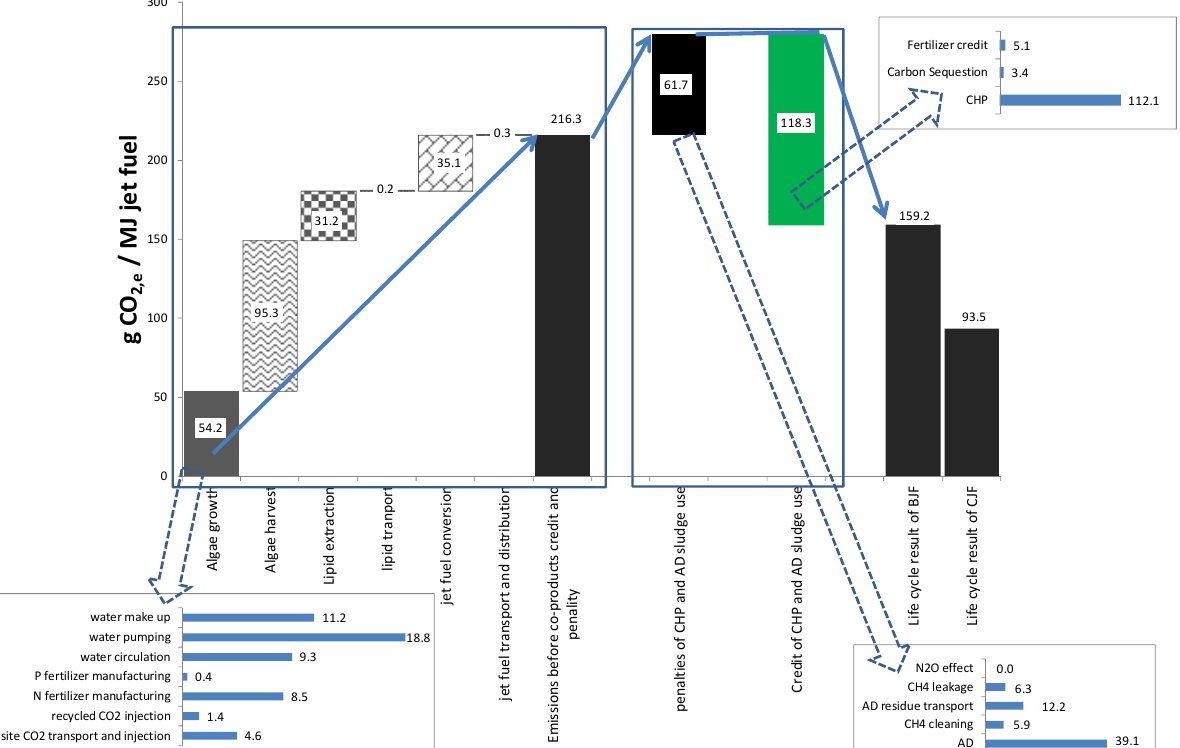
Figure 8. Life-cycle GHG emissions for all stages in the algae jet fuel pathway in China emission from fuel combustion is offset by the intake for algae (the CO 2